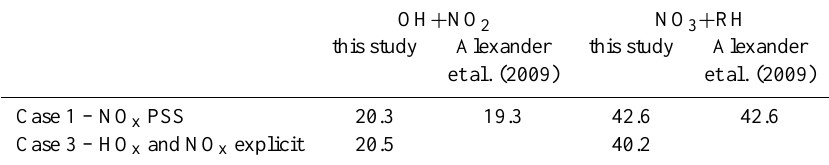
Table 9. Comparison between the DIIS values for OH + NO 2 and NO 3 + RH with the corresponding values assigned to these reactions by Alexander et al. (2009), in ‰ units. The values deduced from the algorithm presented by Alexander et al. (2009) are compared to DIIS values computed using Cases 1 and 3, under the conditions of the base model run (mid-latitudes). OH + NO